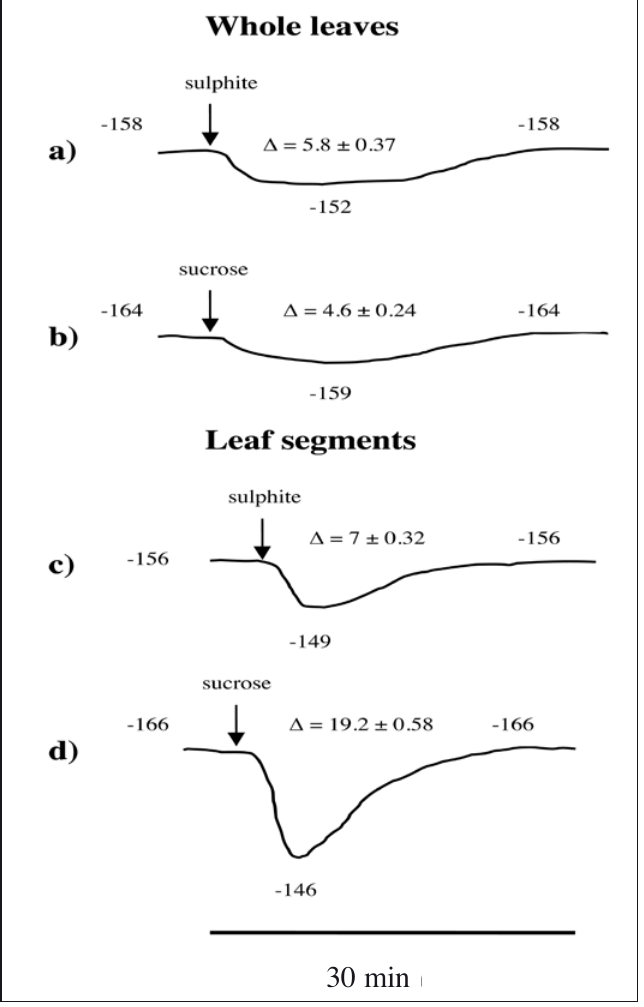
Fig. 2 - Effects of treatments with sucrose and sulphite on whole leaves and leaf segments. All measurements were carried out in light. Numbers preceded by - are negative mV. Electrophysiological traces are representative of five equivalent measurements. Δ is the depolarization (mV) as the mean of five measurements ±